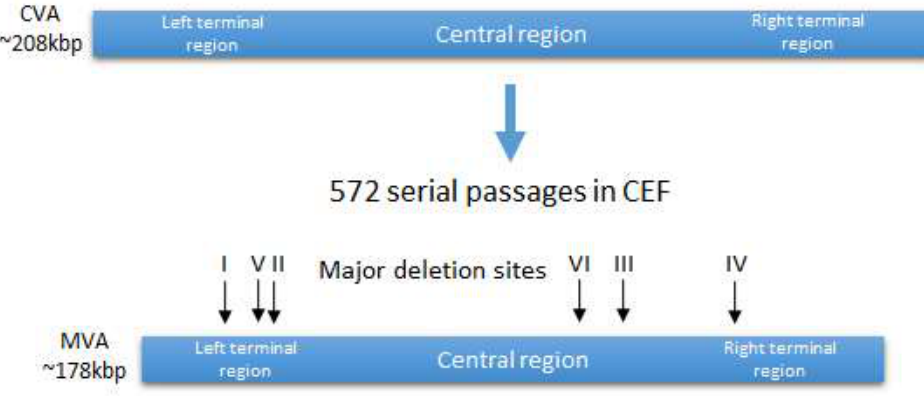
Figure 1. Generation of MVA strain from CVA strain. Location of the major deletion sites. In 2019 [20] and 2020 [21], restoration of the C12L and C16L/B22R genes was identi- fied as necessary to restore the ability of MVA to productively infect mammalian cells.